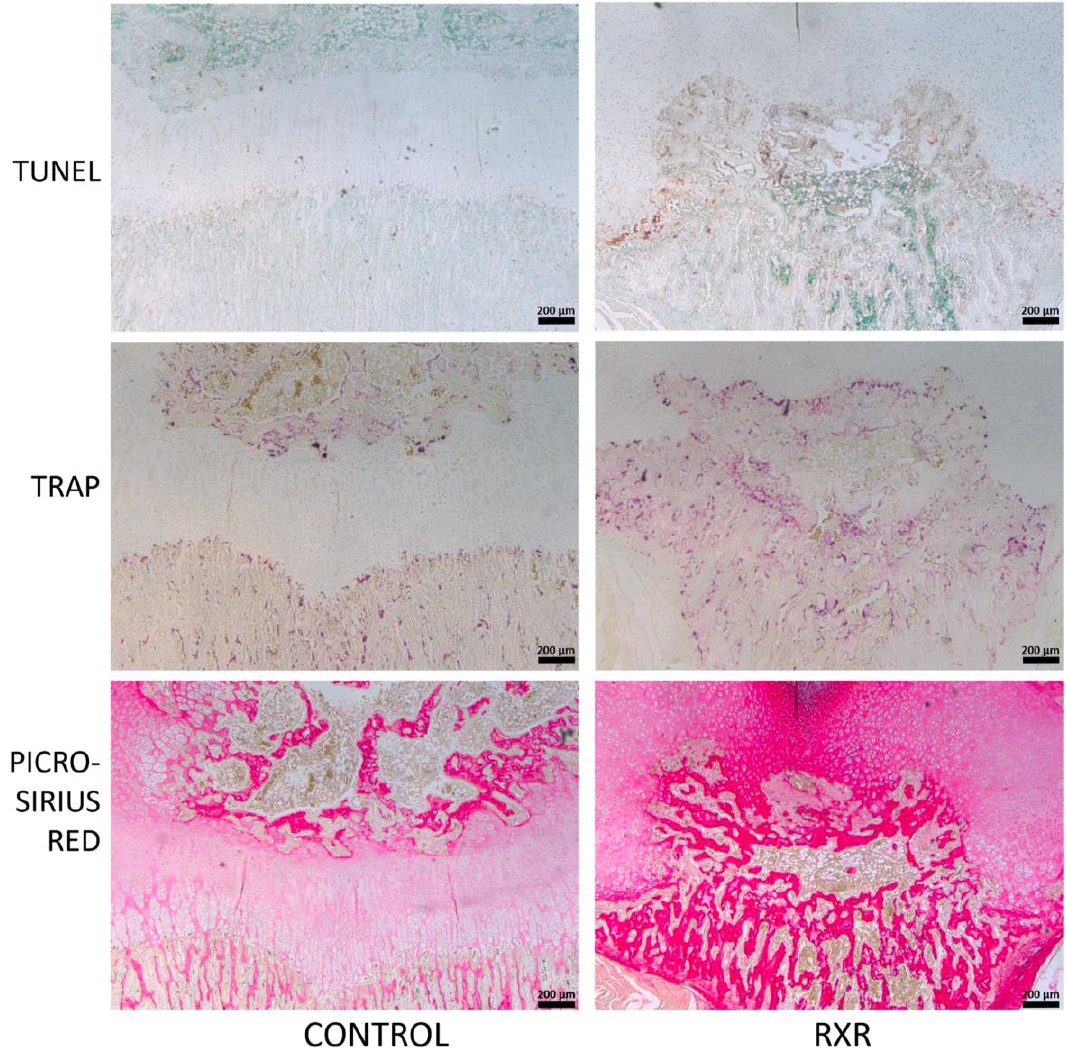
Figure 6. Histological staining of P16 rat tibial sections. Sections of tibiae from rats treated with DMSO or SR11237 were examined by staining for various markers. TUNEL detects cell death; active osteoclasts are stained by TRAP; picro-sirius red stains collagen fibers (scale bar = 200 μm).